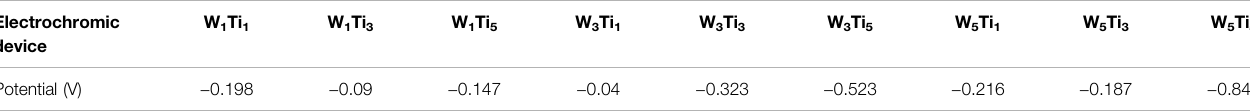
TABLE 1 | Cathodic potentials which turn ON the following electrochromic devices: a) W 1 Ti 1 , b) W 1 Ti 3 , c) W 1 Ti 5 , d) W 3 Ti 1 , e) W 3 Ti 3 , f) W 3 Ti 5 , g) W 5 Ti 1 , h) W 5 Ti 3 and i) W 5 Ti 5 . (W x Ti y where W and Ti indicate the WO 3 and TiO 2 electrodes, respectively and the subscripts x and y indicate their annealing temperature expressed in hundreds, respectively) (see Figure 3 ). Electrochromic